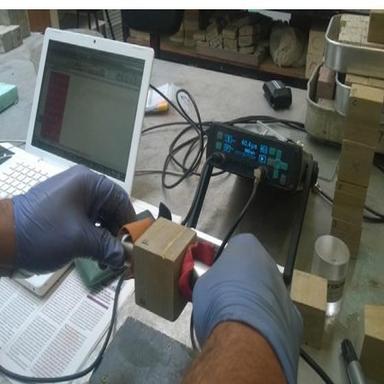
UPV testing procedure (direct testing).